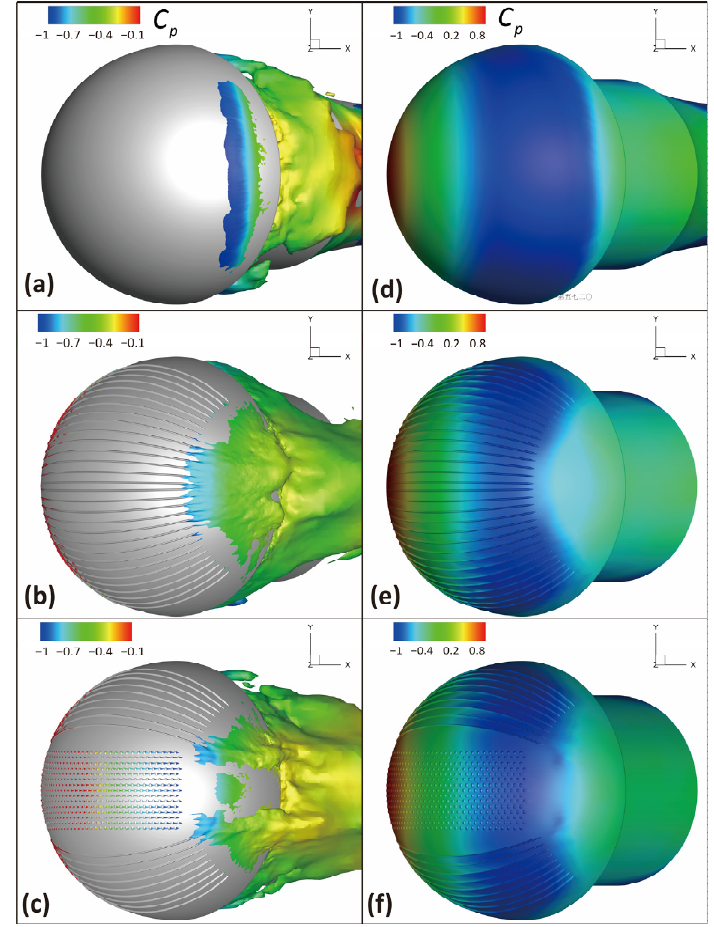
Figure 12. ( a – c ) The iso-surface of zero velocity: ( a ) original, ( b ) riblet, ( c ) bump. ( d – f ) The contour of pressure on the helmet surface: ( d ) original, ( e ) riblet, ( f ) bump.